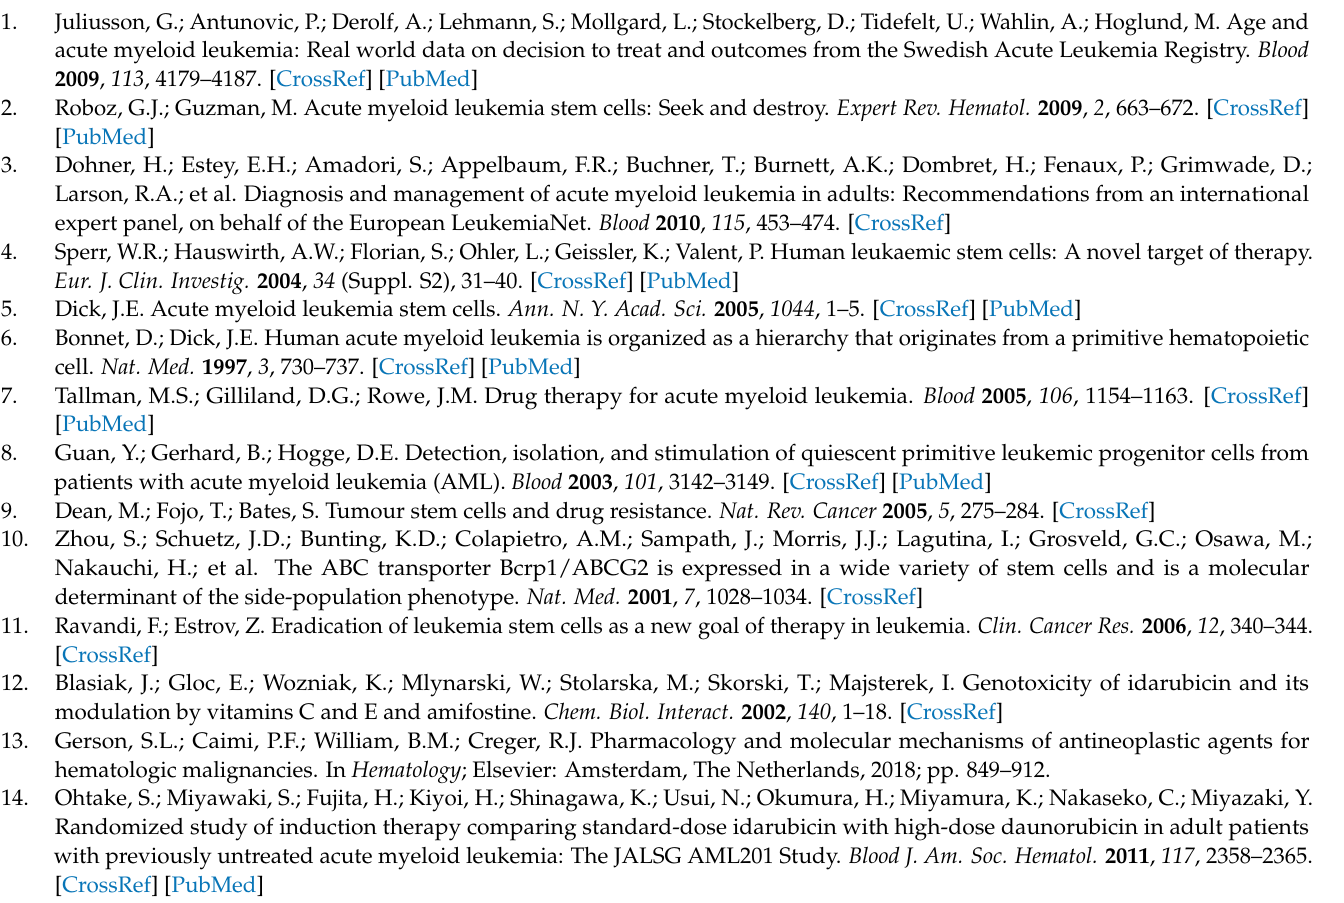
cells, Table S2: IC 50 values of single and co-treatment of Dox or Ida and Cur on KG-1 cells, Table S3: IC 50 values of single and co-treatment of Dox or Ida and Cur on EoL-1 cells, Table S4: IC 50 values of single and co-treatment of Dox or Ida and Cur on U937